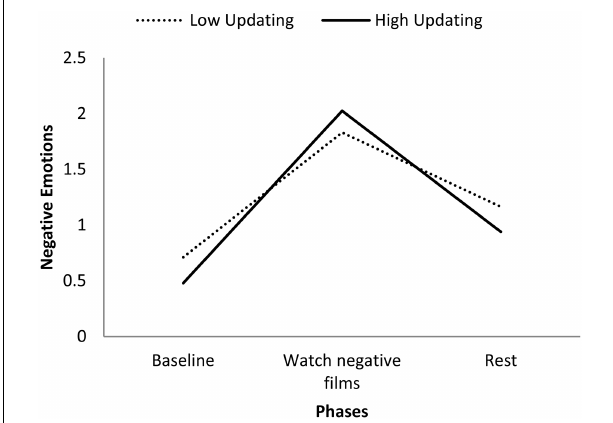
FIGURE 1 | Negative emotions in Study 1 during the different phases of the negative film-clip task. Low and high updating represent participants who scored 2SD below and above the sample average emotional updating ability,